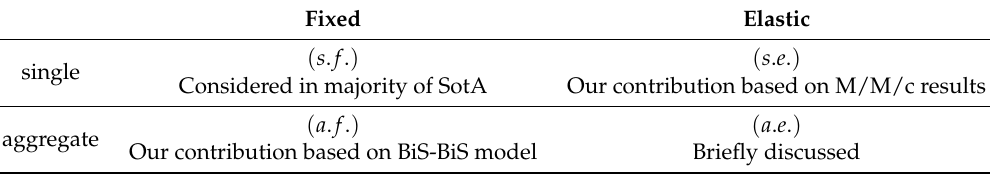
Table 1. The modeled substrate node types in the dimensions of flexibility and abstraction, summarizing our contribution to the state-of-the-art (StoA) and the studied substrate node type